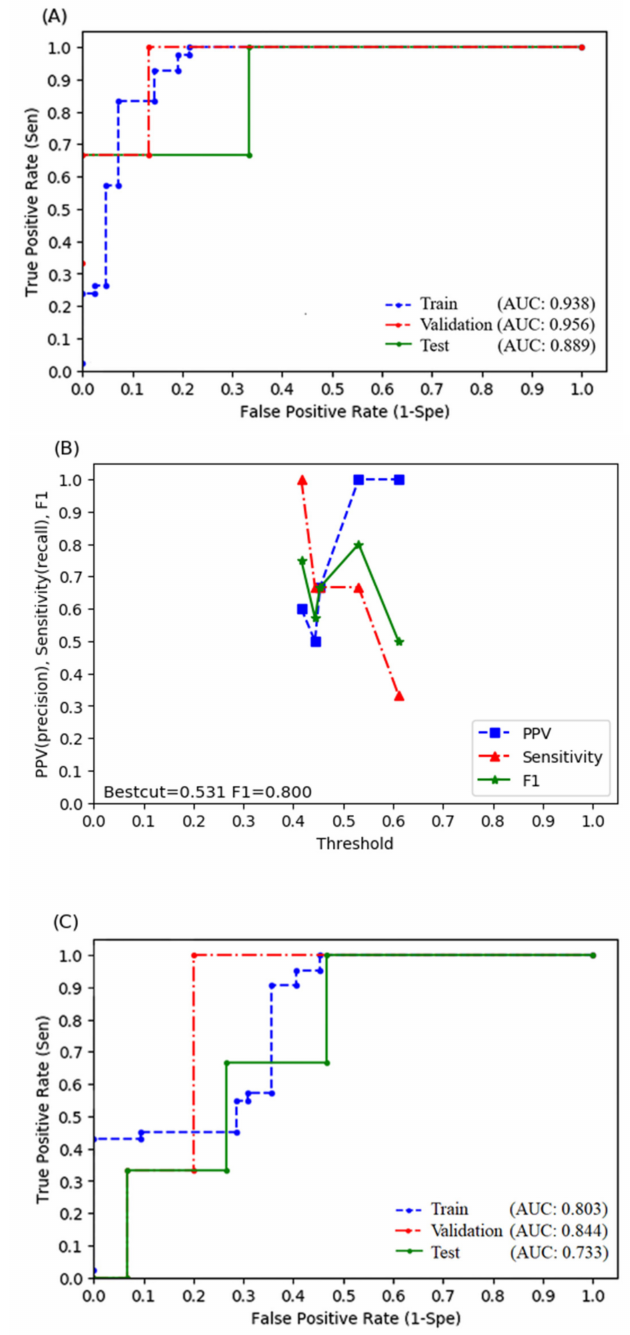
Figure 2. Receiver operating characteristic curve for the logistic regression (LR) model in training, validation, and test sets with ( A ) or without ( C ) radiomic features. ( B ) The relationship between sen- sitivity, positive predictive rate, F1 score, and threshold values of the LR model in the validation